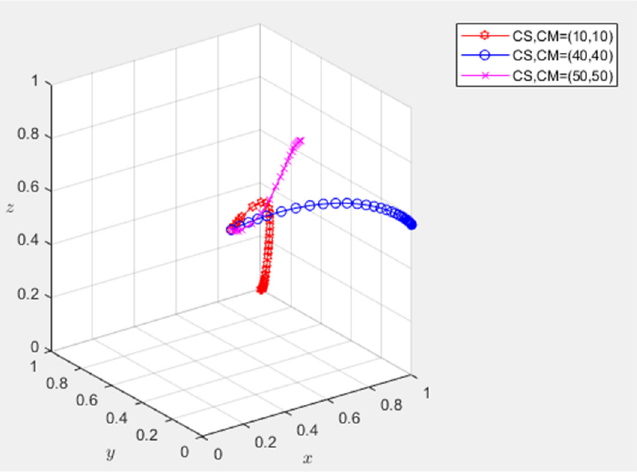
Figure 5. Influence of cost of quality measures.